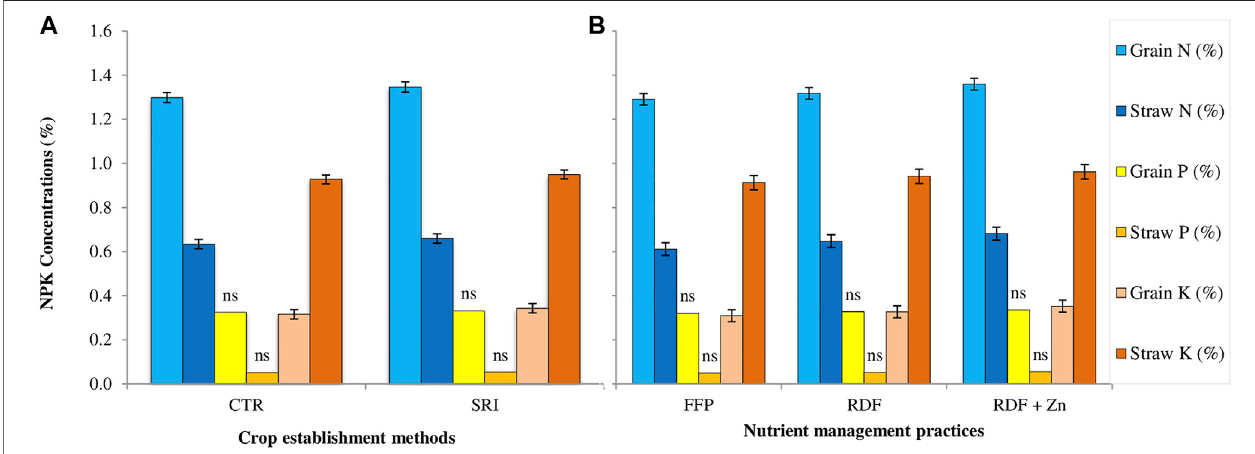
FIGURE5| NPKconcentrations(%)inricegrainsandstrawasin fl uencedbydifferent (A) CEMsand (B) NMPs(4yearsav.).TheverticalbarsindicatetheLSDat p = 0.05. The “ ns ” represent the non-signi fi cant differences at p = 0.05.